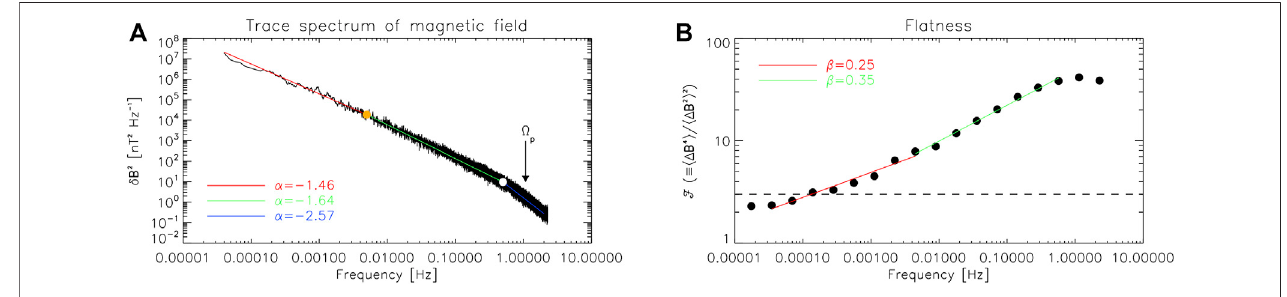
FIGURE 3 | Magnetic fi eld trace power spectrum δ B 2 (A) and fl atness F as a function of spacecraft frequency (B) for the slow-wind plasma fl ow sampled by PSP during quasico-rotationwiththeSun.Color-codedpower-law fi tsat threedifferentrangesofscalesaredisplayed: therelativescaling exponents aregiveninthelegend. The arrow indicates the proton gyro-frequency Ω p . The horizontal dashed line in (B) refers to fl uctuations with Gaussian distributions at all